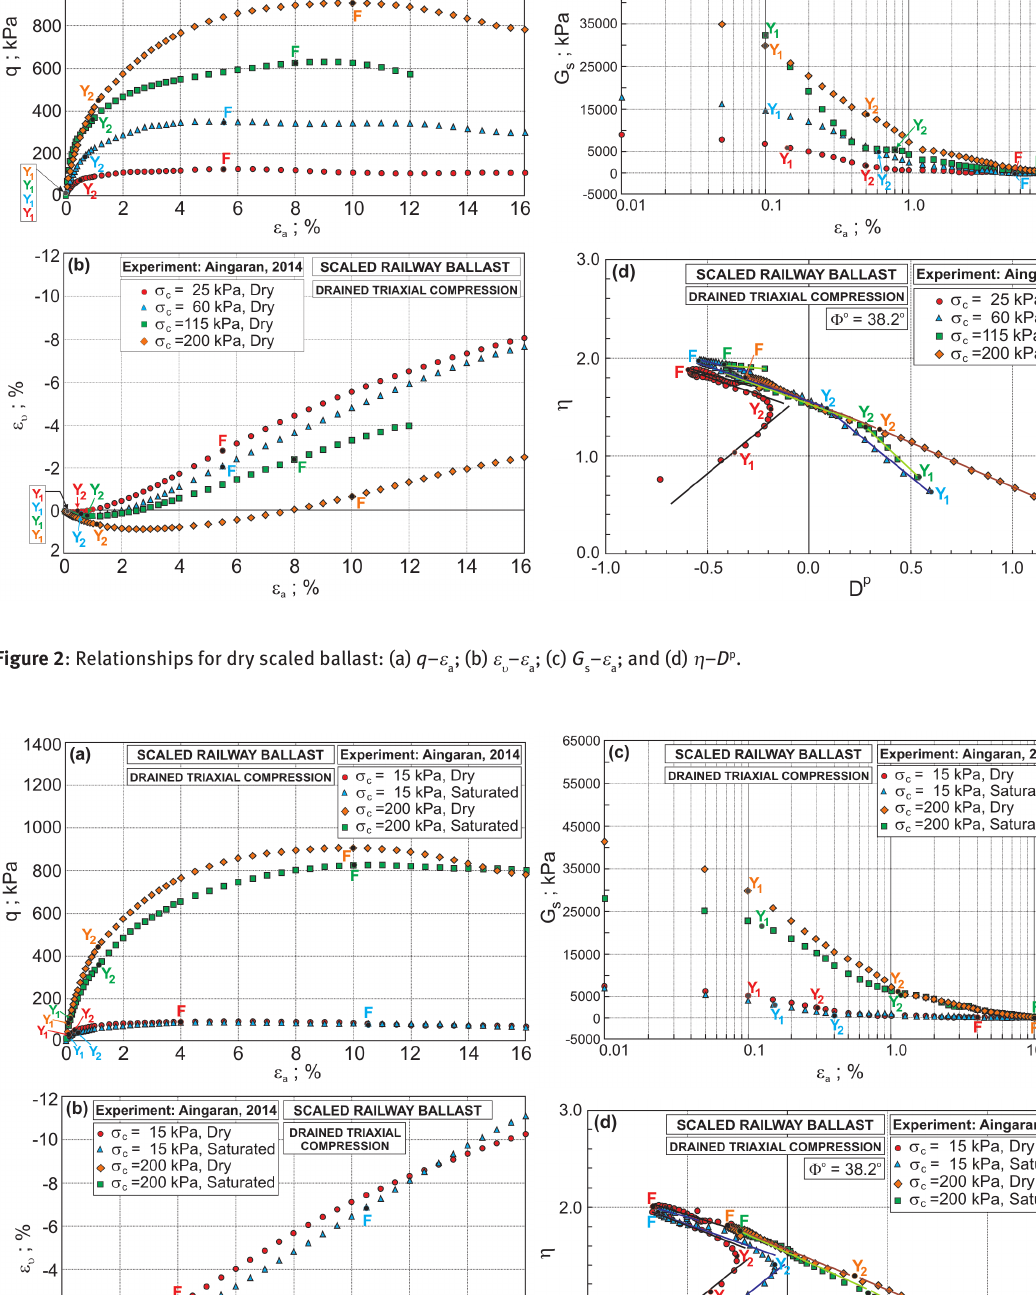
; (b) e – e ; (c) G – e ; and (d) h – D p u a a s a